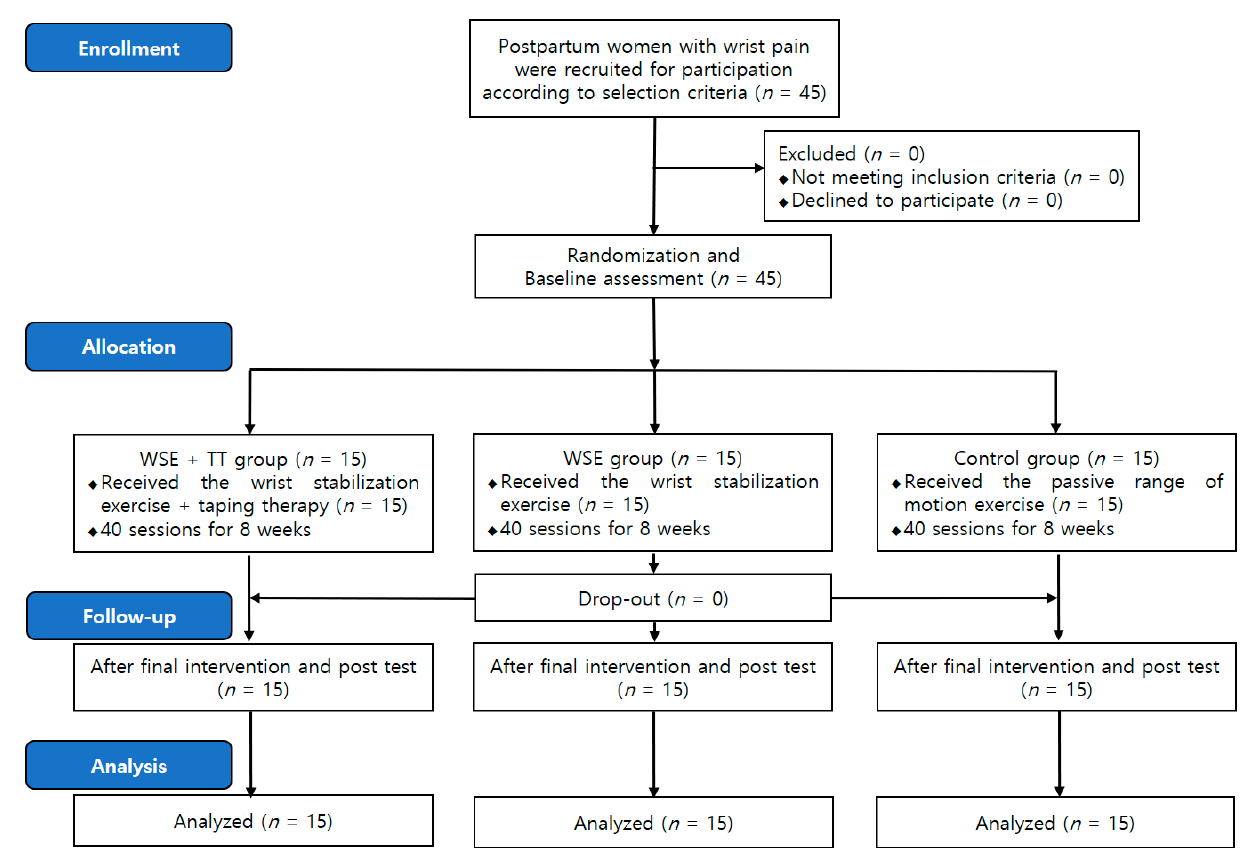
Figure 1. Flow diagram of participants throughout the study.